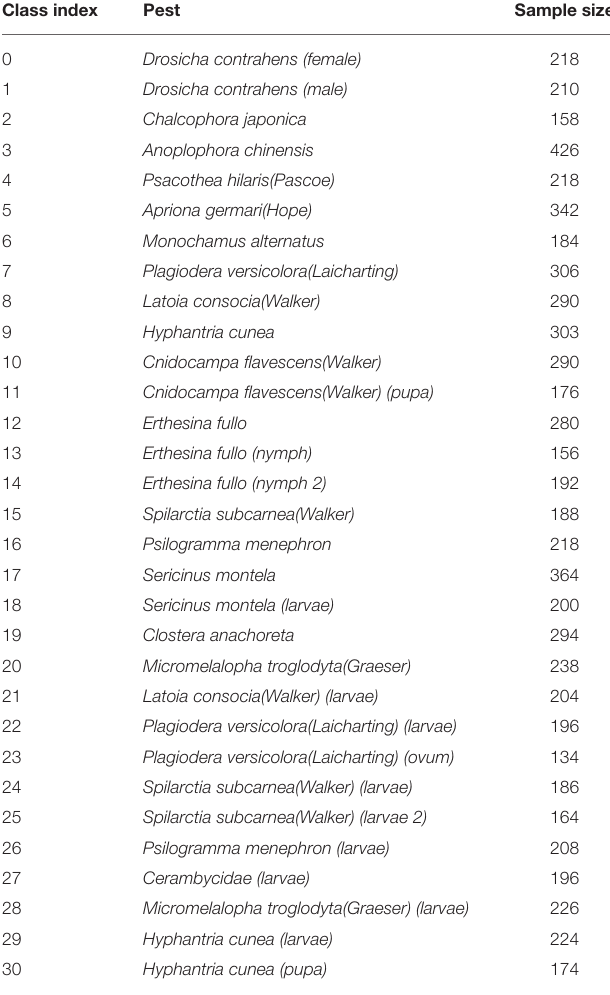
TABLE 1 | Details of Forestry Pest